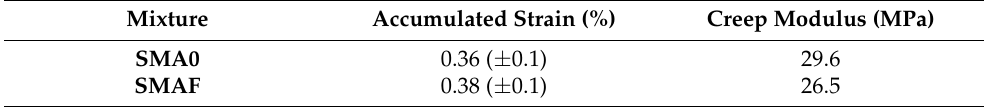
Table 10. Average RLAT